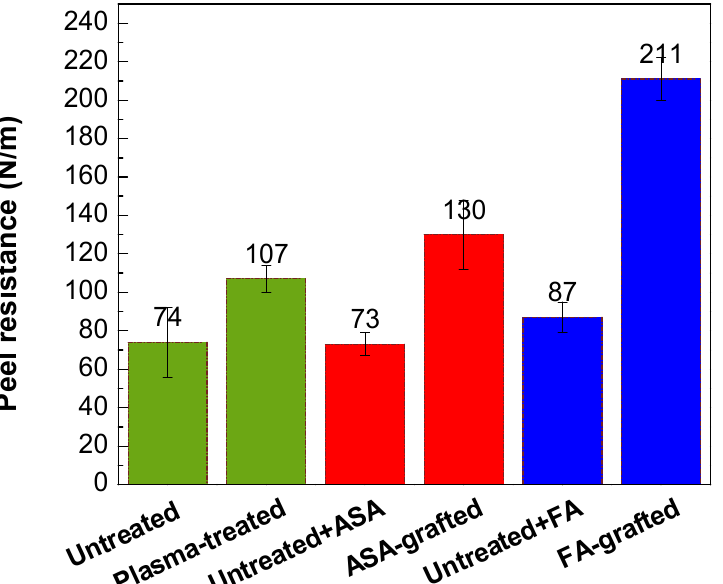
Figure 8. Peel resistance of PLA/Al laminate.